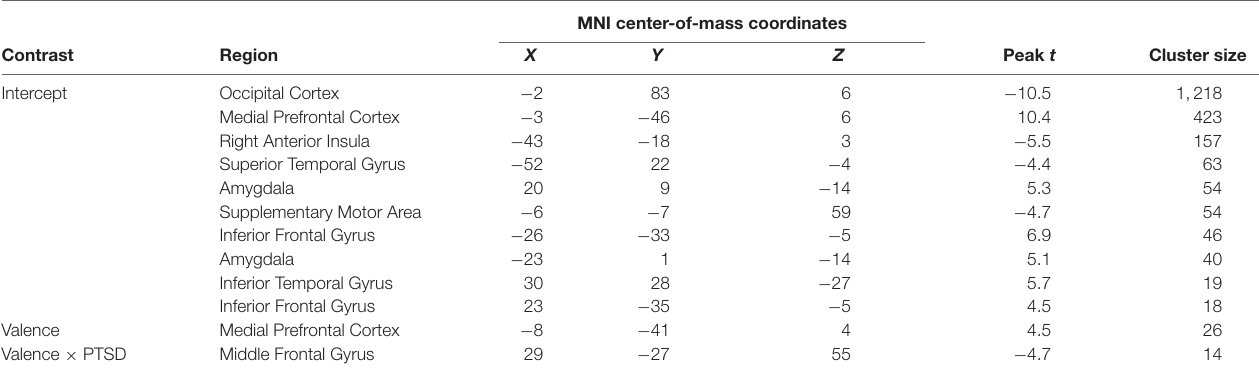
TABLE 2 | Results from the voxel-wise LMEMs on forward encoding maps.